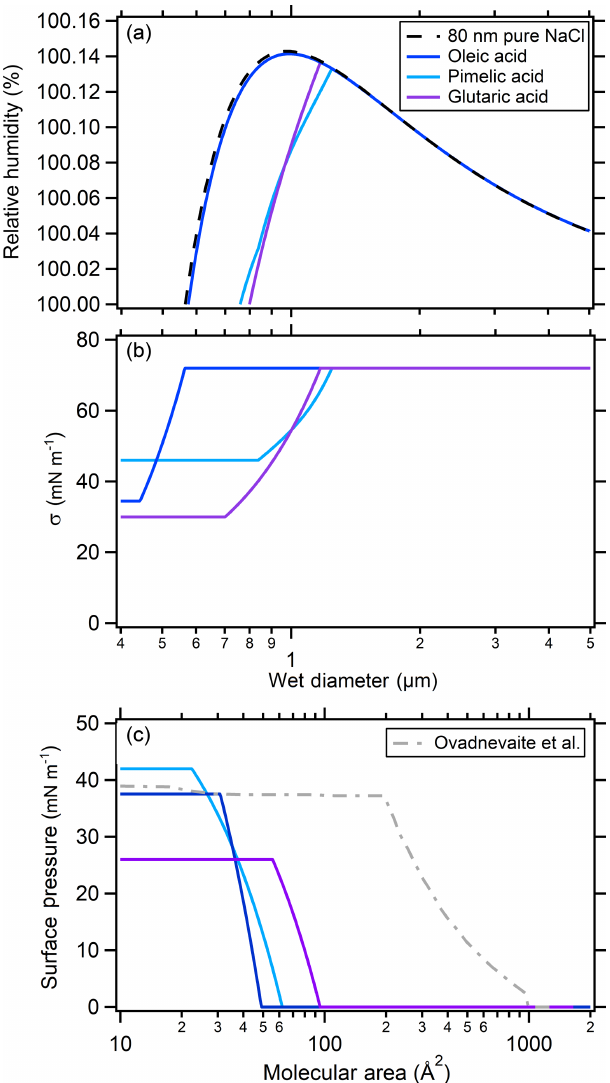
Figure 7. Film-model-derived (a) relative humidity and (b) surface tension ( σ ) as a function of wet diameter for uncoated 80nm NaCl particles (dashed black line) or 80nm NaCl particles coated with oleic acid (dark blue line), pimelic acid (light blue line), and glu- taric acid (purple line) until ε org = 0 . 80. Film model parameters for oleic acid are from this study, while the parameters for glu- taric acid and pimelic acid were taken from Ruehl et al. (2016). (c) Surface pressure ( π ) as a function of molecular area for the coated-particle model systems in (a) and (b) . Also shown is the π curve derived from Ovadnevaite et al. (2017) based on the reported wet diameter and σ , assuming ρ org = 1 . 6gcm − 3 and a molecular weight = 332gmol − 1 .